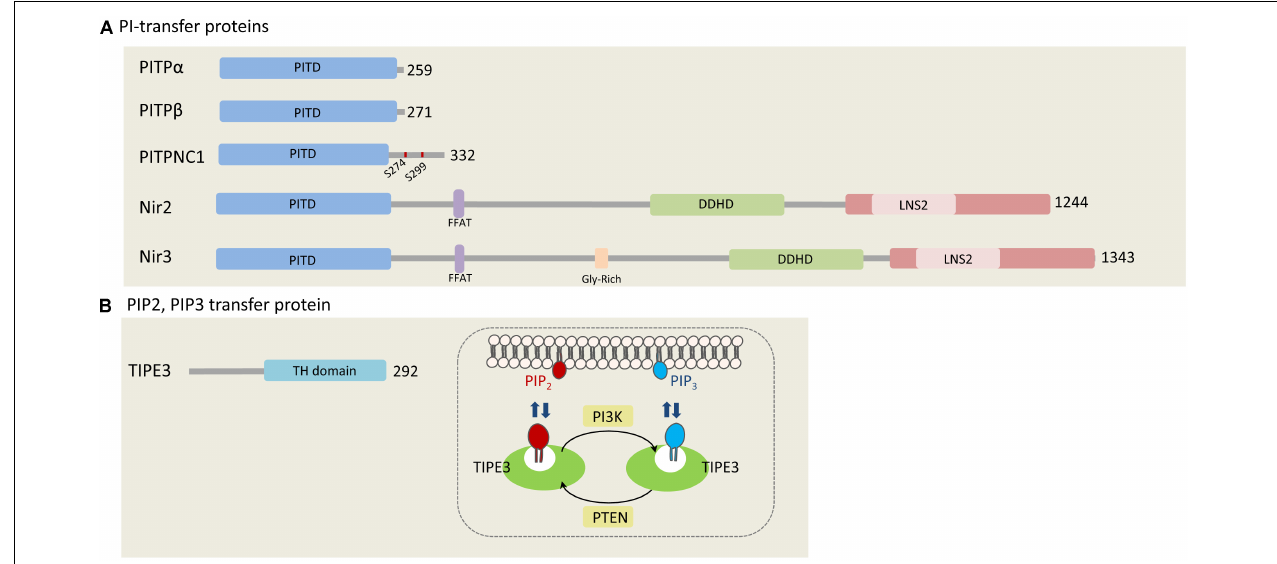
FIGURE 1 | Phosphatidylinositols transfer proteins. (A) PI-transfer proteins. The five human PI-transfer proteins can be divided into small proteins consisting of a single PI-transfer domain (PITD) including PITP α / β and PITPNC1, and the multi-domains containing proteins Nir2 and Nir3. Shown are the PITD, the FFAT motif, DDHD, and the C-terminal LNS2 (Lipin/Nde1/Smp2) domain. Glycine rich region is found only in Nir3 (Lev, 2004). PITPNC1 phosphorylation sites (S274 and S299), which bind 14-3-3, are represented as red dots on PITPNC1 protein (Halberg et al., 2016). (B) TIPE3, a PIP 2 , and PIP 3 transfer protein. TIPE is the only protein that is known to transfer phosphoinositides. It preferentially binds PIP 2 and PIP 3 , and contributes to increase their levels at the PM by mediating efficient supply of PIP 2 and presenting it to PI3K to produce PIP 3 (Fayngerts et al., 2014). The numbers at the right side of each protein indicate the length of each protein in amino